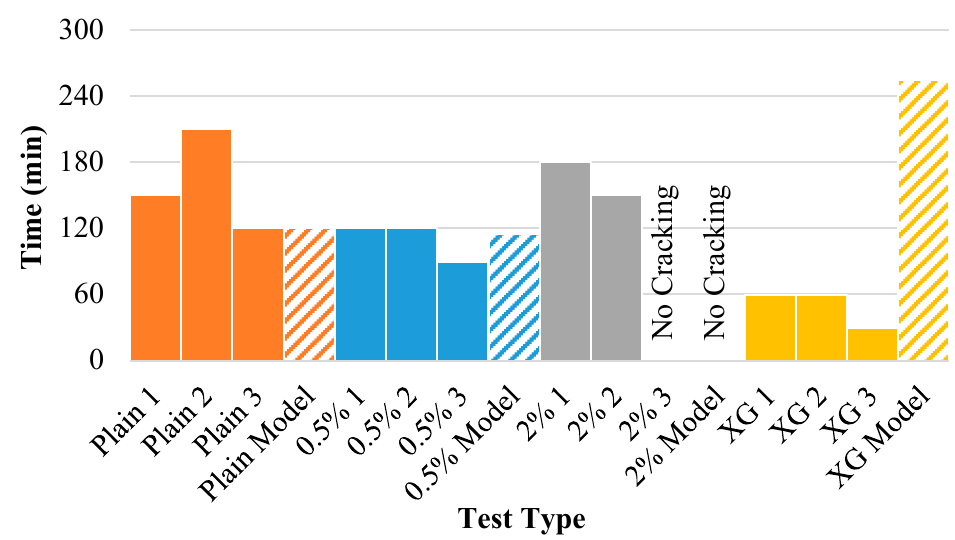
Figure 15. Internal crack time for each of the experiments and model results.